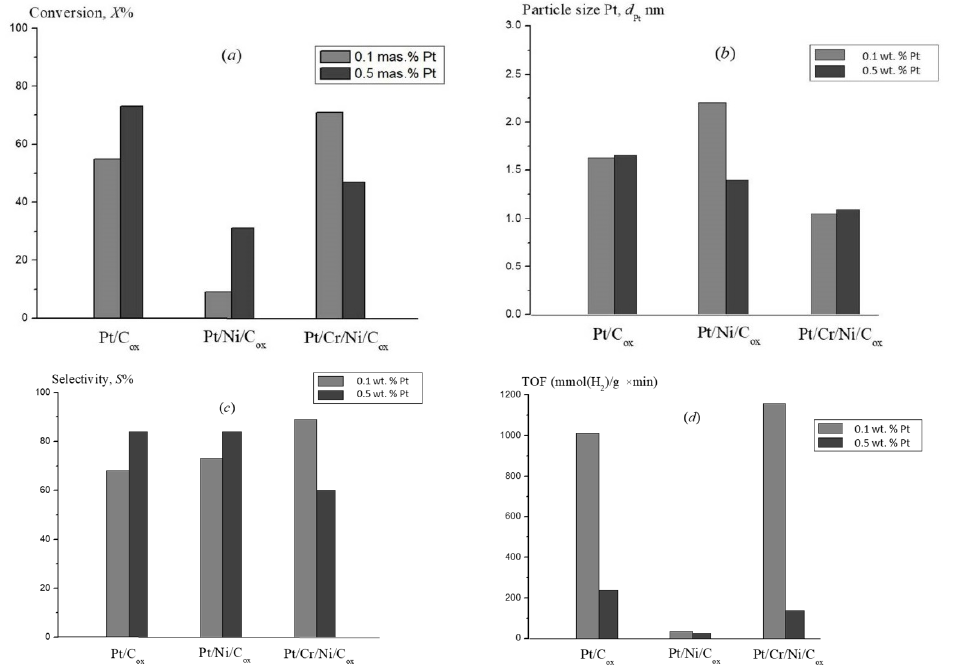
Figure 3. Bicyclohexyl ( a ) dehydrogenation conversions, ( b ) average Pt particle sizes, ( c ) selectivity to biphenyl, and ( d ) TOF values for mono-, bi-, and trimetallic catalysts with a Pt content of 0.1 and 0.5 wt.%.